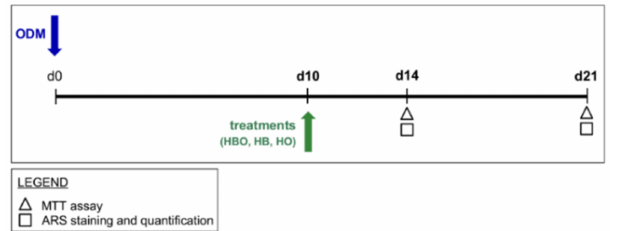
Figure 9. Schematic experimental design of treatments starting after osteogenic pre-commitment of hADSCs. hADSCs are pre-di ff erentiated in ODM for 10 days (d10) before treatment with HBO, HB, or HO. Each treatment is performed daily for 60 min from the tenth day to d21 of culture. Tests for evaluating cell metabolic activity and osteogenic di ff erentiation, as evidenced in the legend, are performed at d14 and